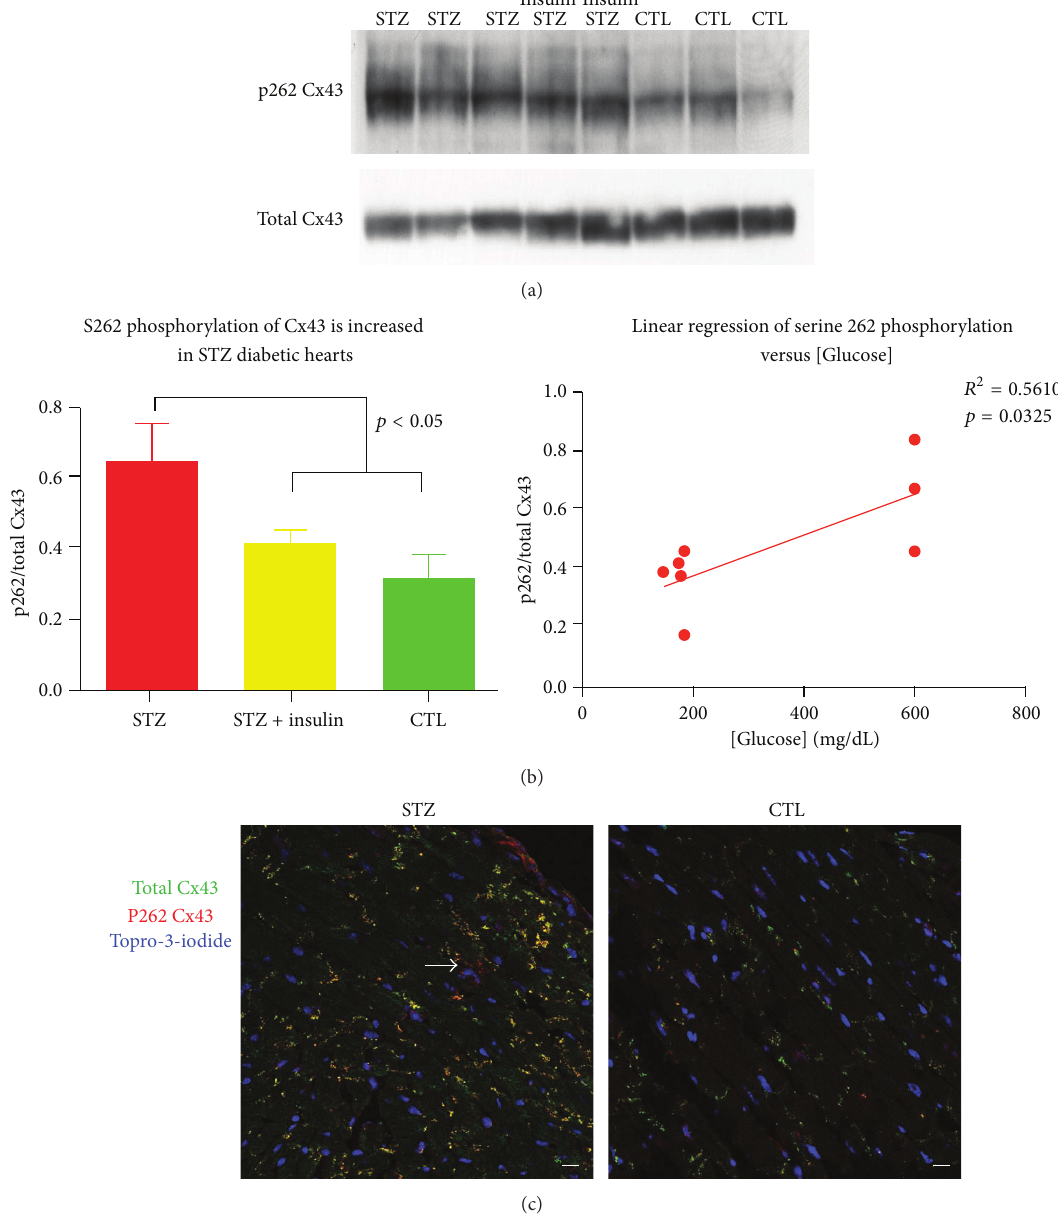
Figure 5: Cx43 phosphorylation at serine 262 is enhanced in the STZ-treated diabetic heart. Representative western blot (a) labeling serine 262 and total Cx43 of the tissue homogenates of ventricular apices harvested from STZ-treated mice, insulin-treated STZ mice, and control mice. (b) Serine 262 phosphorylated Cx43/total Cx43 ratio is significantly increased in STZ-treated mice, 𝑝 < 0.05 (left), and serine 262 phosphorylation/total Cx43 ratio correlates with blood glucose level in diabetic animal (right). (c) Representative confocal images of immunolabeling of STZ and control mice for phosphorylated serine 262 (red) and total Cx43 (green) demonstrating increased serine 262 labeling in the STZ mouse. Arrow indicates perinuclear (nonjunctional) p262 labeling. Scale bar = 10 𝜇